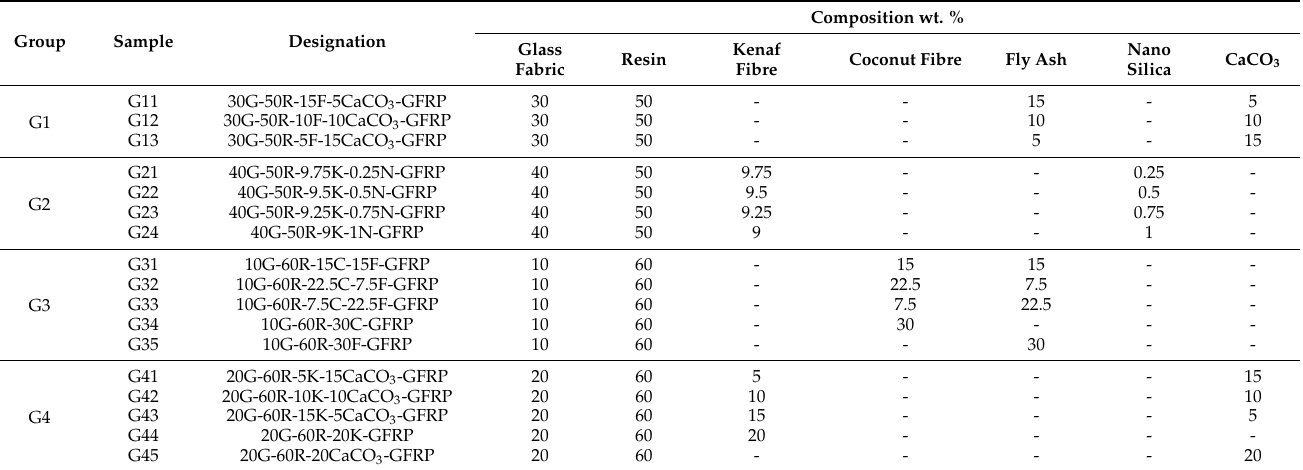
Table 1. The designation of hybrid GFRP